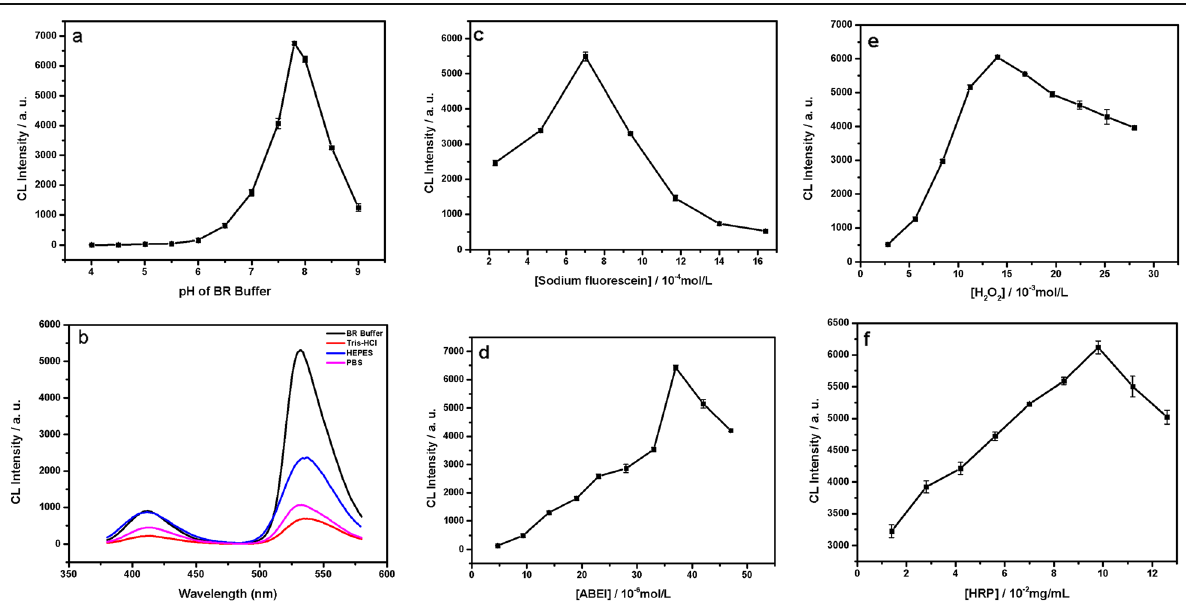
Fig. 2 a Effect of BR buffer pH on CL emission. Experimental conditions: c(ABEI)=0.037 mmol/L, c(sodium fluorescein)=0.701 mmol/L, c(HRP)=0.098 mg/mL, c(H 2 O 2 )=0.014 mol/L. b CL kinetic curves of the sodium fluorescein-ABEI – H 2 O 2 – HRP system at different buffered solution: BR buffer (black curve), PBS buffer (pink curve), Tris-HCl buffer (red curve), HEPES buffer (blue curve). Experimental conditions: c(ABEI)=0.037 mmol/L, c(sodium fluorescein)=0.701 mmol/L, c(HRP)= 0.098 mg/mL, c(H 2 O 2 )=0.014 mol/L. c Effect of sodium fluorescein concentration on CL emission. Experimental conditions: c(BR)=0.018 mmol/L at pH 7.8, c(ABEI)=0.037 mmol/L, c(HRP)=0.098 mg/mL, c(H